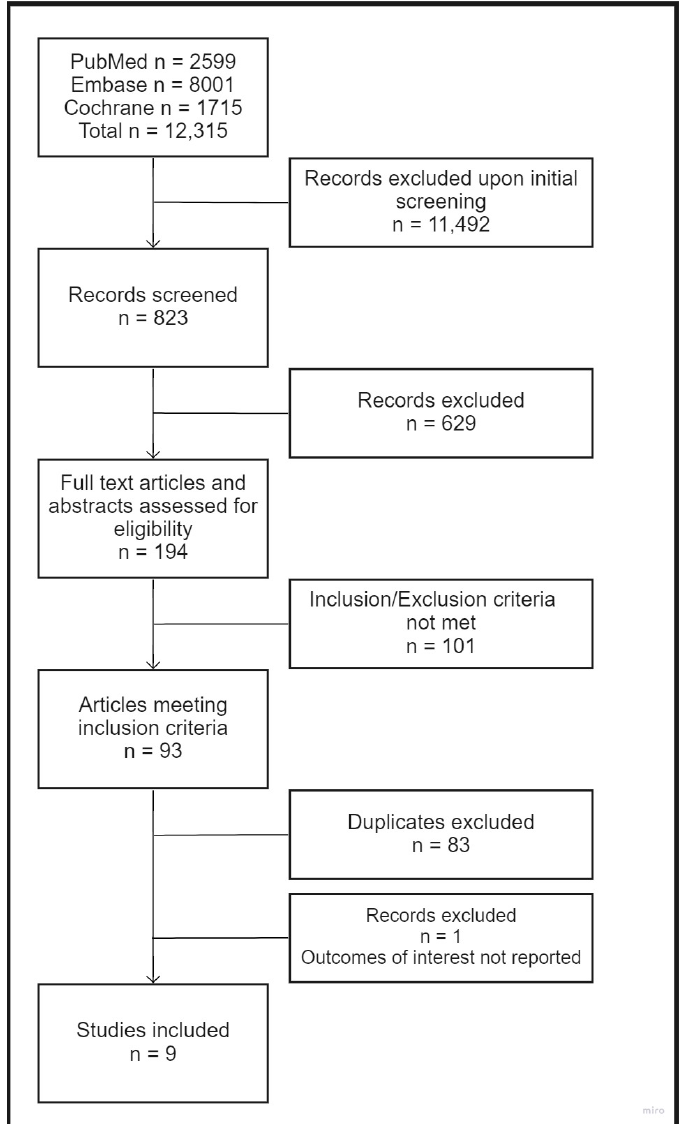
Figure 1. Flowchart of studies considered for inclusion.